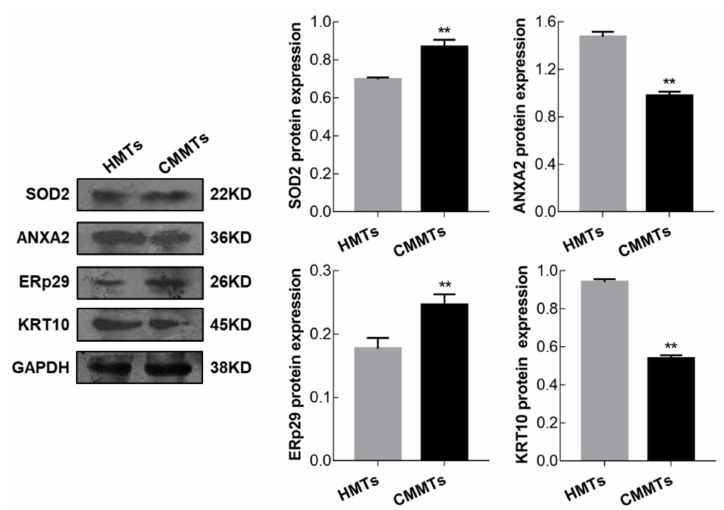
Figure 7. Expressions for selected randomly four DEPs were detected by Western blot. Data show means ± SD (n = 3). ** p < 0.01. HMTs, healthy mammary tissues. CMMTs, mammary tissues with clinical mastitis. DEPs, di ff erentially expressed